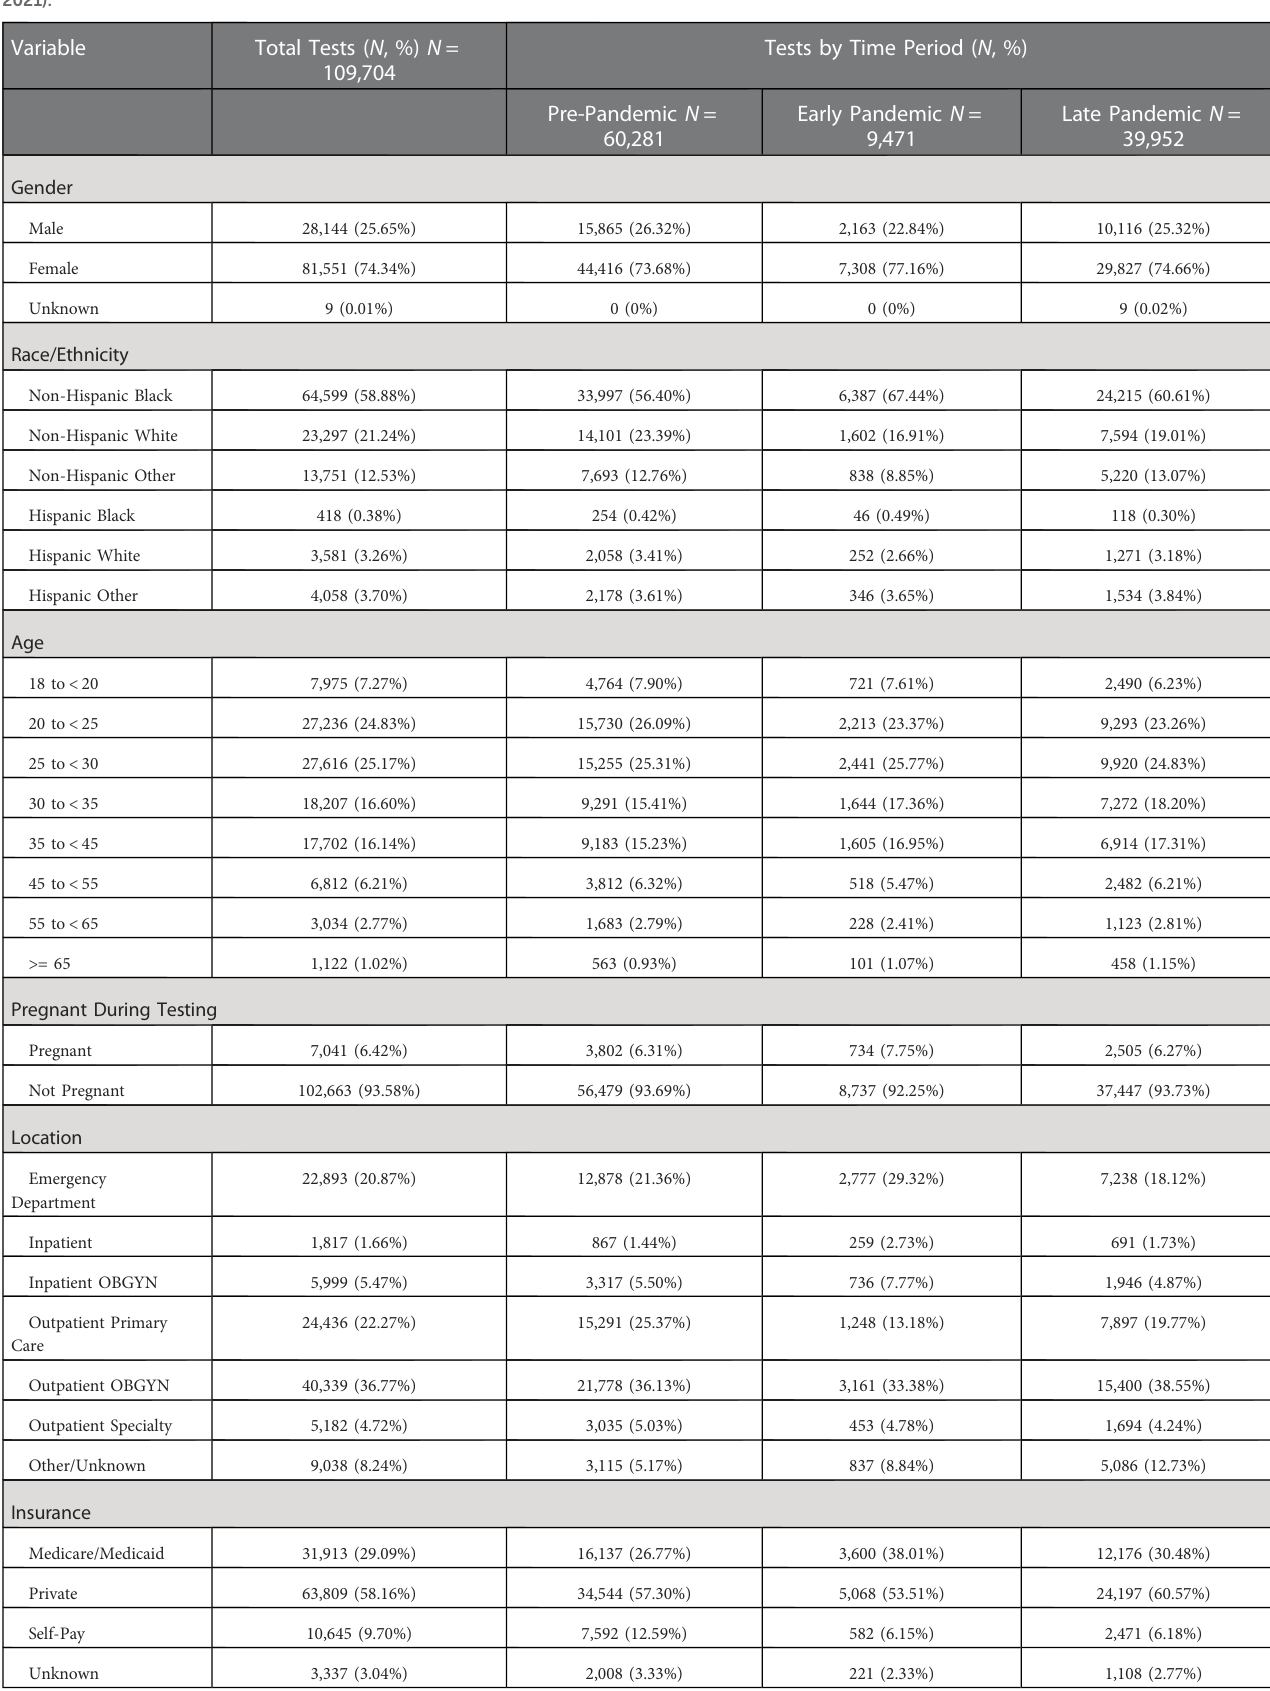
TABLE 1 Demographic characteristics of patients tested for gonorrhea, chlamydia, or trichomonas from November 1, 2018, through July 31, 2021, by COVID- 19 time period: pre-pandemic (November 1, 2018 - March 14, 2020), early pandemic (March 15 - July 31, 2020), and late pandemic (August 1, 2020 - July 31,